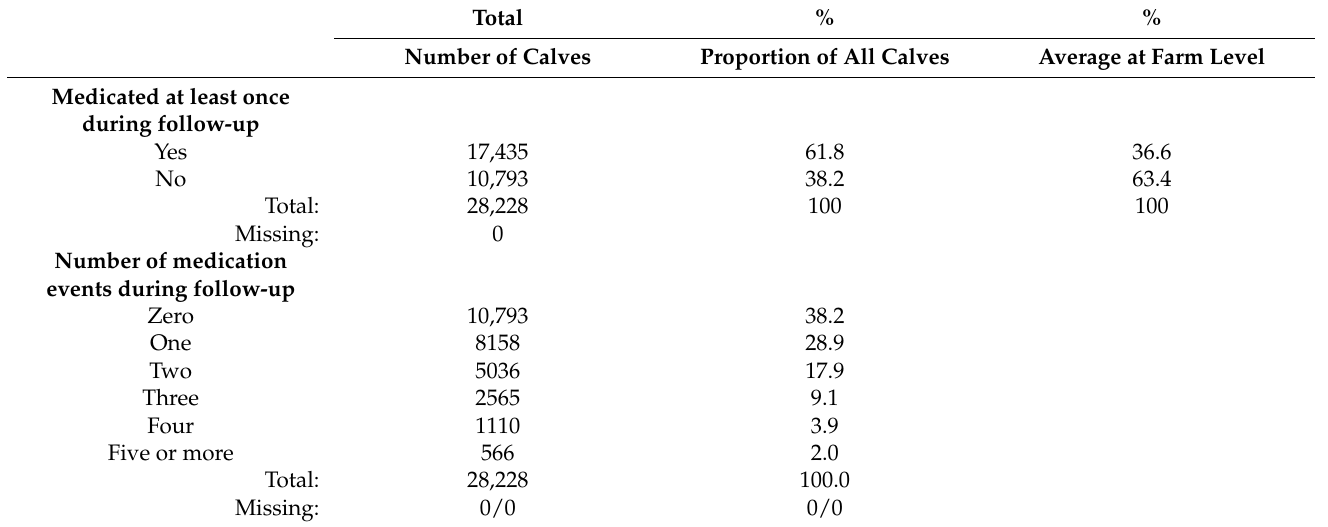
Table 7. Descriptive statistics of outcome variables (medicated 0/1 and number of medications) of 28,228 calves on 87 farms. The study included 23,946 calves reared on 45 specialized calf rearing farms, 3746 calves reared on 28 integrated beef production farms and 536 calves reared on 14 finishing farms for weaned calves.